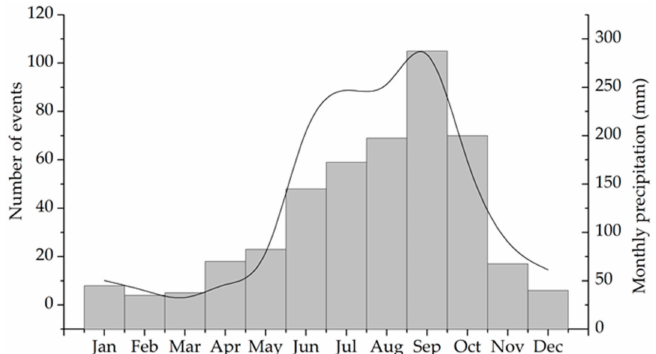
Figure 3. Number of flood events in Veracruz (black line) and average monthly precipitation (gray bars) for the period